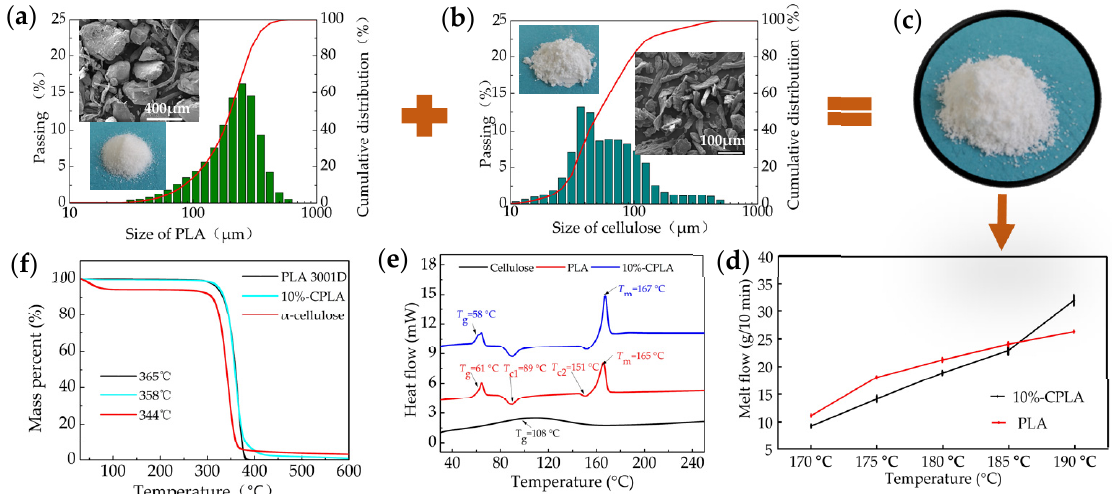
Figure 1. Preparation of 10%-CPLA mixture: ( a ) characteristics of PLA 3001D; ( b ) characteristics of cellulose; ( c ) the appearance of 10%-CPLA; ( d ) melt flow of PLA 3001D and 10%-CPLA; ( e ) DSC curves of 10%-CPLA and its components; ( f ) TGA curves of 10%-CPLA and its components.